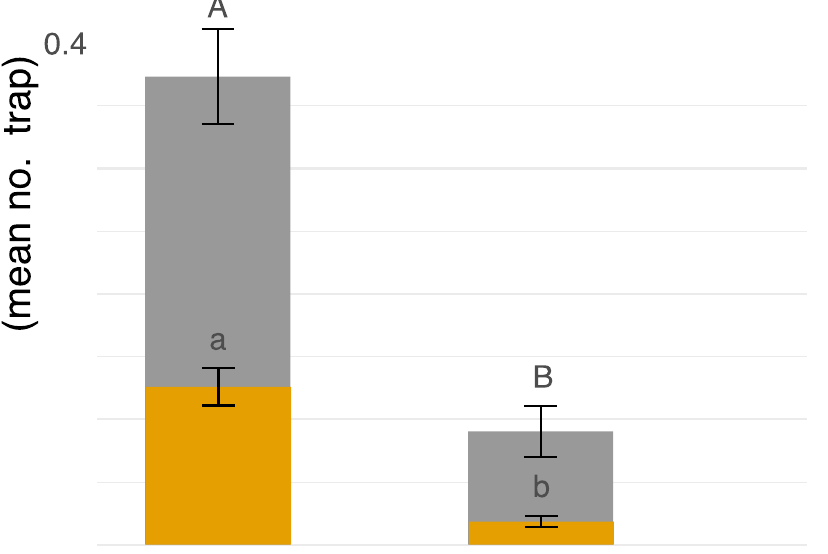
Figure 4. Male = grey, Female = gamboge. On the x-axis, “high” is high-input commercial chemical management, “low” is low-input fungicide-only chemical management. On the y-axis, blue, white, and yellow traps were pooled together, and displayed as average count of flies per trap location. The uppercase letters represent linear contrasts for males and lowercase letters for females in relation to management strategy ( α = 0.05).